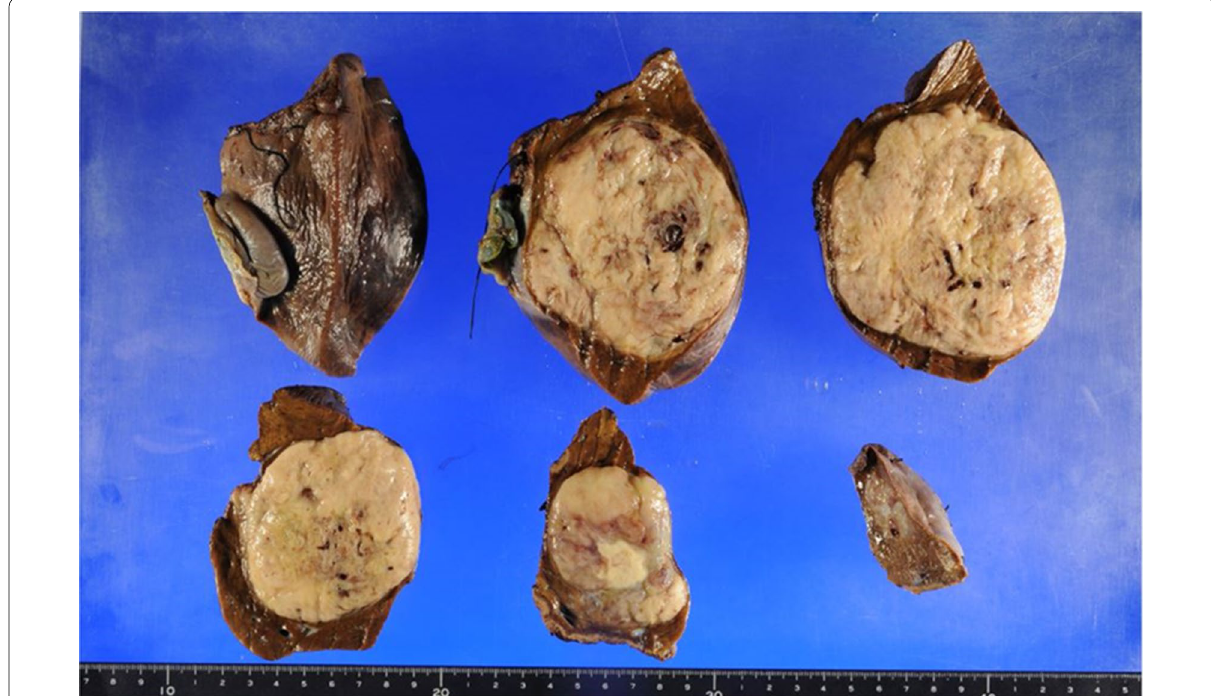
Fig. 4 Histopathological findings (macroscopic). A yellowish white, solid 10